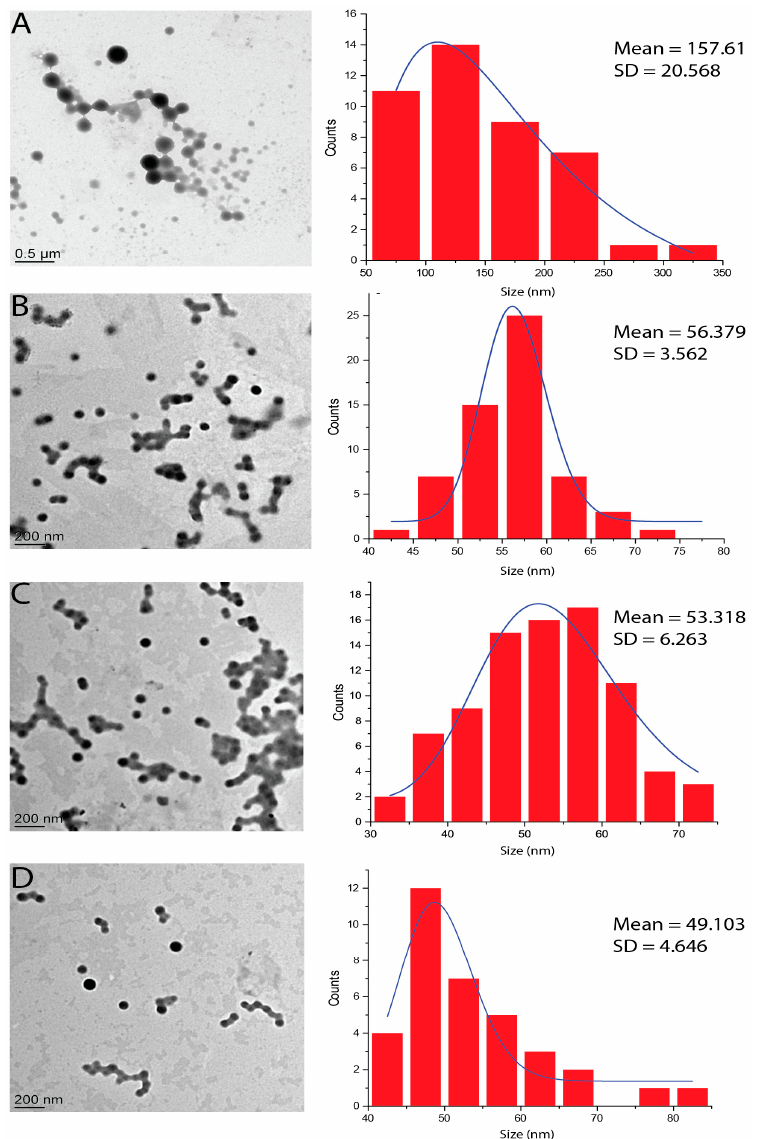
Figure 7. TEM images for different samples and their associated particle size histogram: ( A ) BSA2.5%, S/NS2/5; ( B ) BSA2.5%, S/NS1/2; ( C ) BSA2%, S/NS2/5; and ( D ) BSA2%, S/NS1/2. Images were analyzed using ImageJ and results are represented as mean size and standard deviation